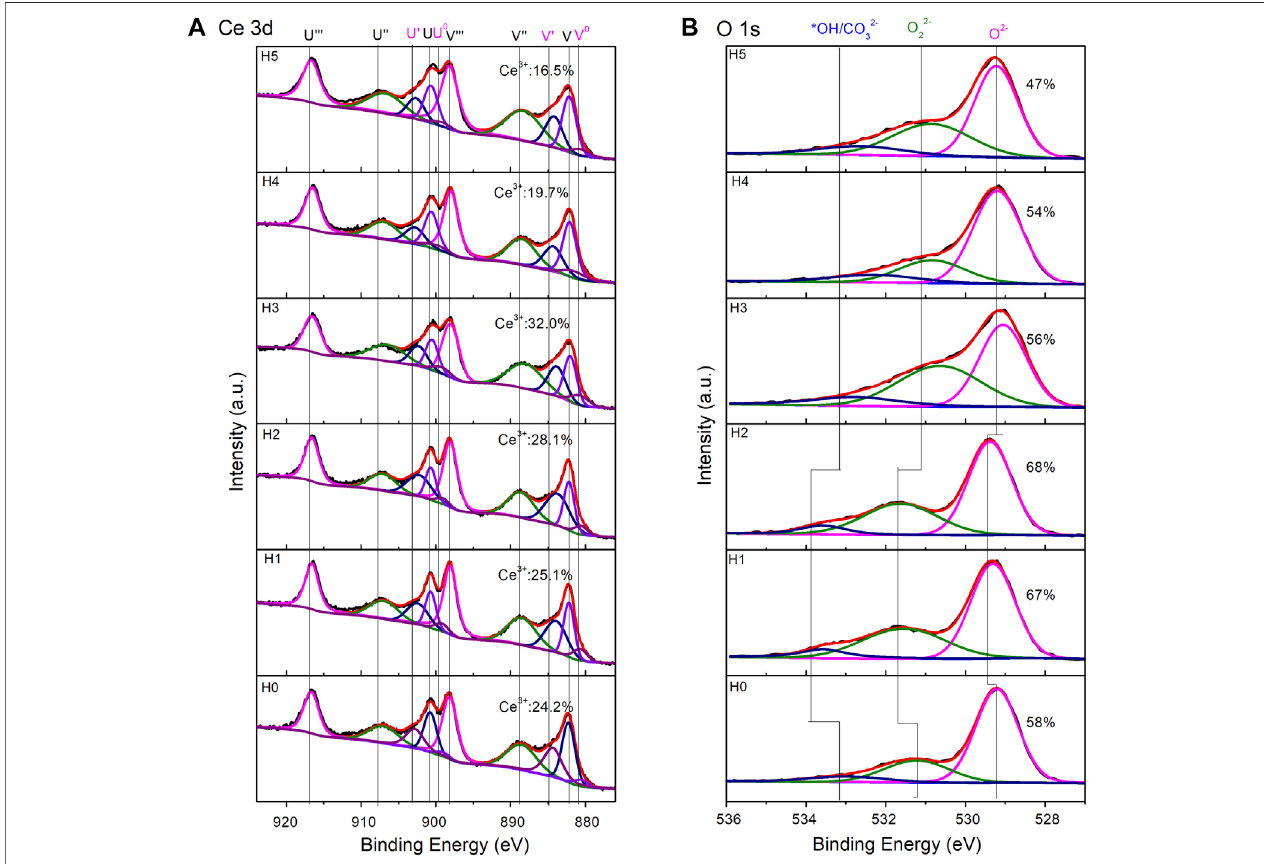
FIGURE 5 | XP spectra of CeO 2 by the combined microwave – ultrasonic method and calcined at 500 ° C in air for 1 h. (A) is the region of Ce 3d, in which V 0 , V ′ , U 0 , and U ′ belong to Ce 3+ . (B) is the region of O 1 s.